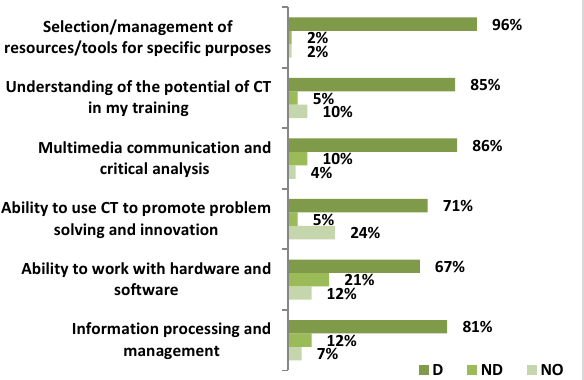
Figure 4. Percentage of answers regarding the technological